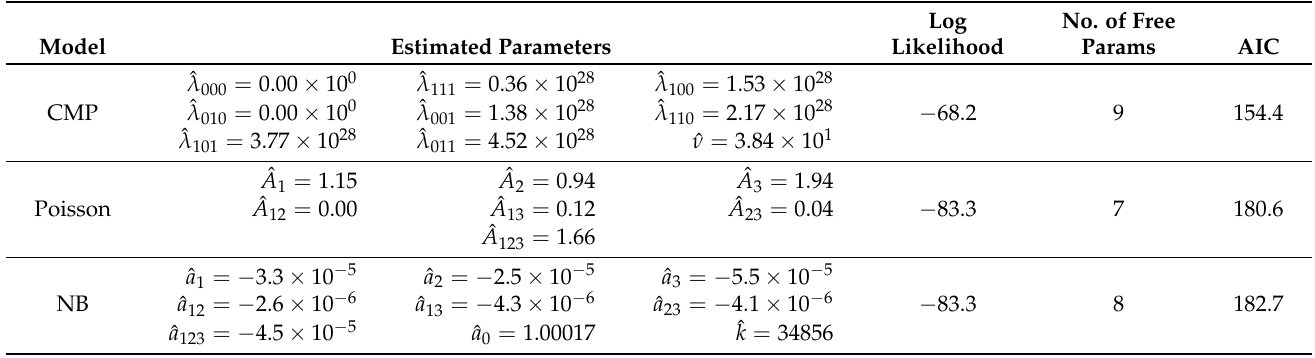
Table 6. Estimation results associated with the NBA All-Star data based on various assumed trivariate models: Conway– Maxwell–Poisson (CMP), Poisson, and negative binomial (NB). Respective log-likelihood and Akaike Information Criterion (AIC) values are also